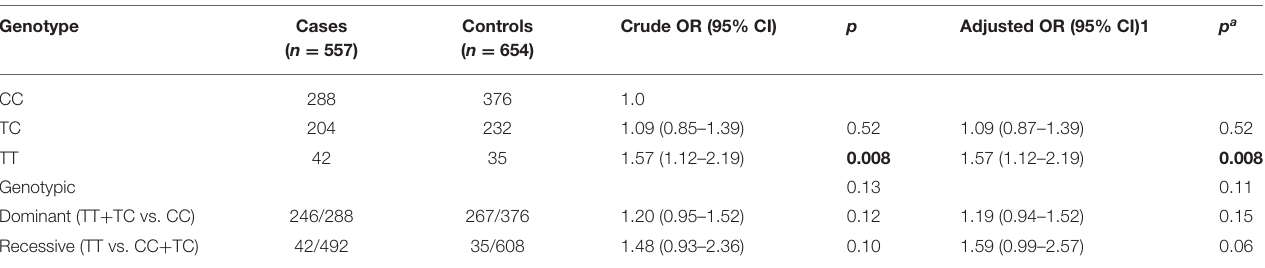
TABLE 1 | Association between HAAO rs3816183 T > C polymorphism and hypospadias susceptibility.